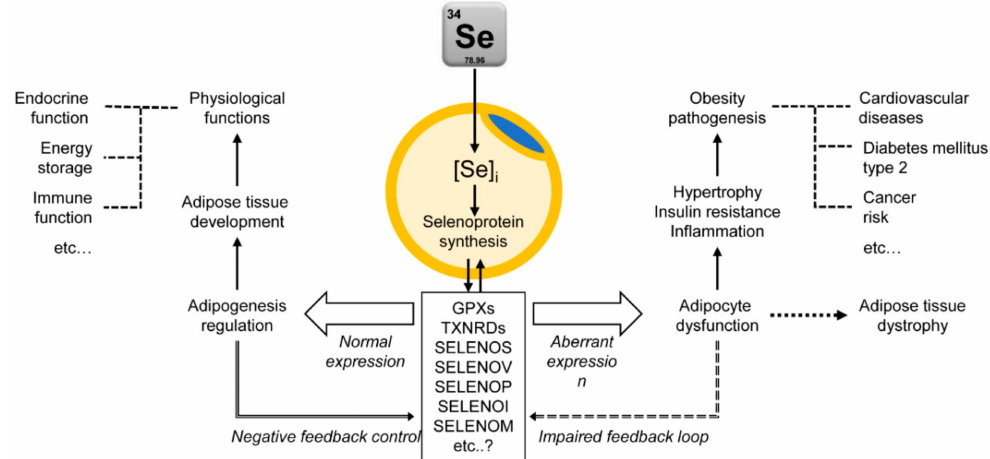
Figure 4. The proposed role of Se in adipose tissue physiology and obesity pathogenesis. Adipocyte intracellular Se levels [Se] i are associated with activity of selenoprotein metabolism machinery (SECISBP2, Sephs2, and Scly) regulating adipose tissue selenoprotein expression. Endoplasmic reticulum resident selenoproteins (SELENOS, SELENOV, etc.) together with mitochondrial and cytosolic GPXs and TXNRDs were shown to interfere with adipocyte development and functioning. Adequate Se supply (including its transport with SELENOP), as well as normal selenoprotein expression, is essential for regulation of adipogenesis and physiological development of adipose tissue, leading to its physiological functioning, including energy storage, endocrine, and immune functions. In turn, both low and increased expression of adipocyte selenoproteins may result in adipose tissue dysfunction contributing to adipocyte hypertrophy or dystrophy, insulin resistance, and adipose tissue inflammation. It is hypothesized that impairment of negative feedback mechanism may partially underlie the association between aberrant selenoprotein expression and adipocyte dysfunction. However, the particular relationship between Se intake, systemic Se levels, adipose tissue Se and adipocyteselenoproteinexpressionisnotclear. GPXs, glutathioneperoxidases; Scly,selenocysteinelyase; Se, selenium; SECISBP2, selenocysteine insertion sequence-binding protein 2; SELENOI / -M / -P / -S / -V, selenoprotein I, M, P, S, and V; Sephs2, selenophosphate synthetase 2; TXNRDs, thioredoxin reductases.